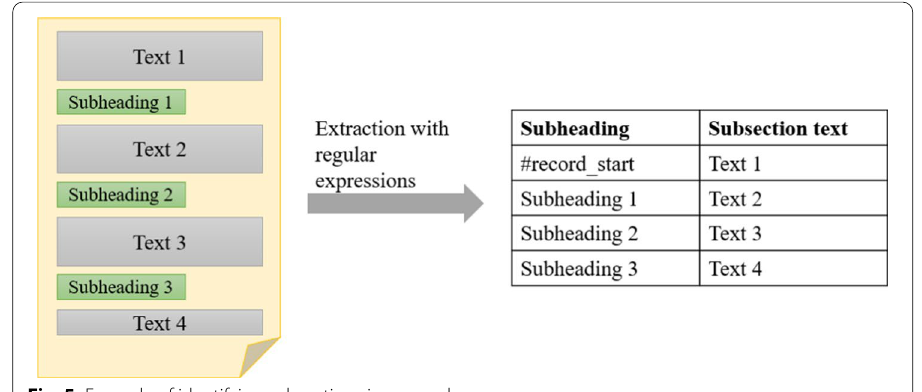
Fig. 5 Example of identifying subsections in a